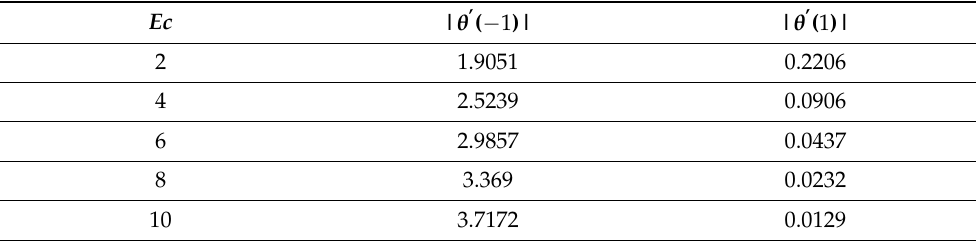
Table 5. Eckert parameter E c effects on numerical heat transfer for Re = 3, α = 2 and Pr = 6.2.